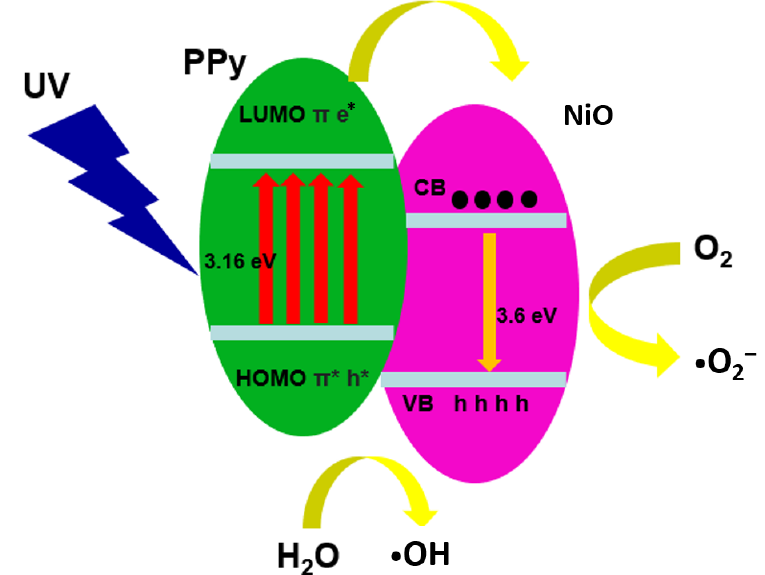
Fig. 7. Mechanism of photodegradation for PPy-NiO catalyst under UV Fig. 7